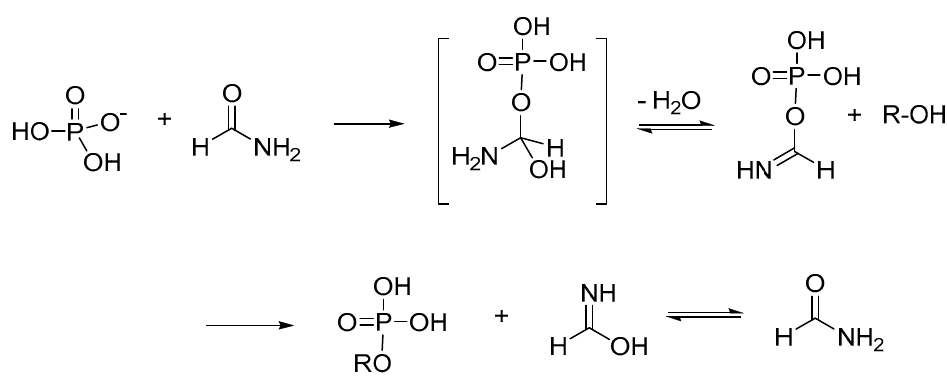
Figure 4. NH 2 COH-based organo-catalysis mechanism for the phosphorylation of alcohols under thermal conditions.